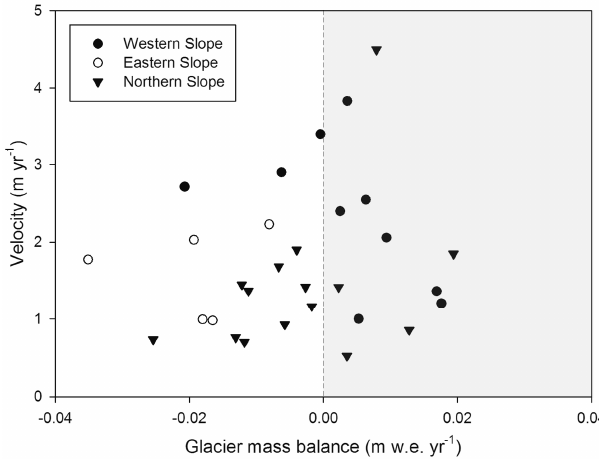
Figure 7. Scatterplot of mass changes of glaciers in the western, eastern, and northern parts of the PIF.